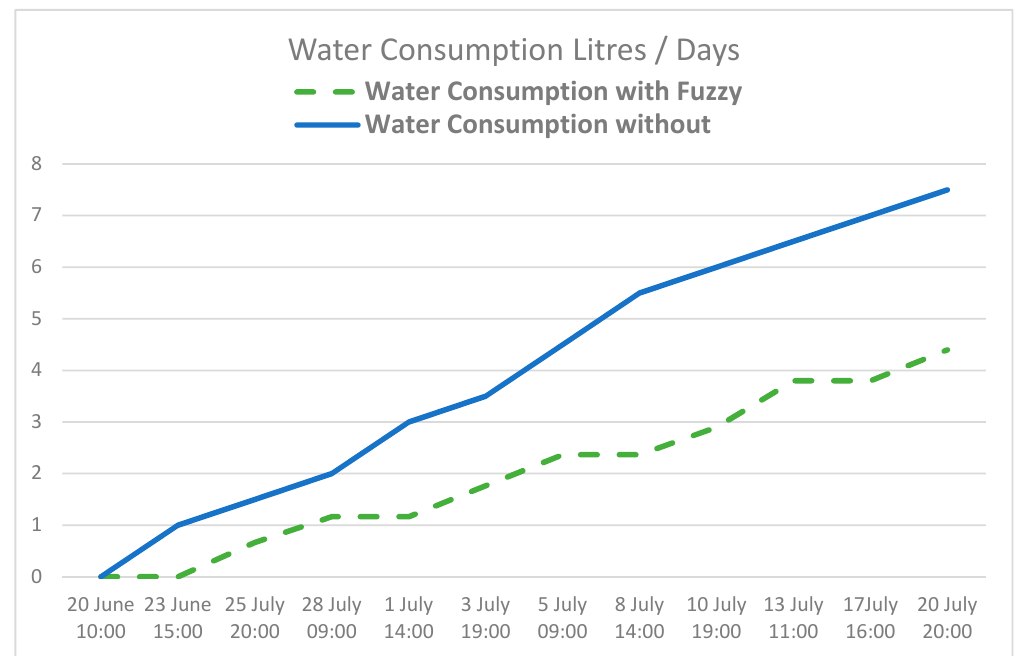
Figure 24. Total water consumption in the system using the fuzzy logic system.